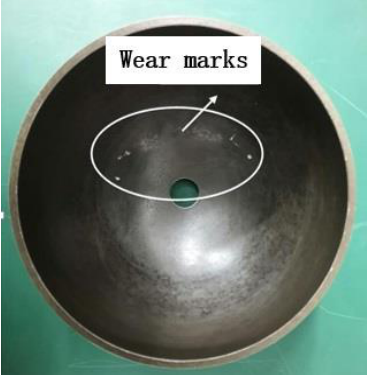
Figure 13. Schematic diagram of rotor